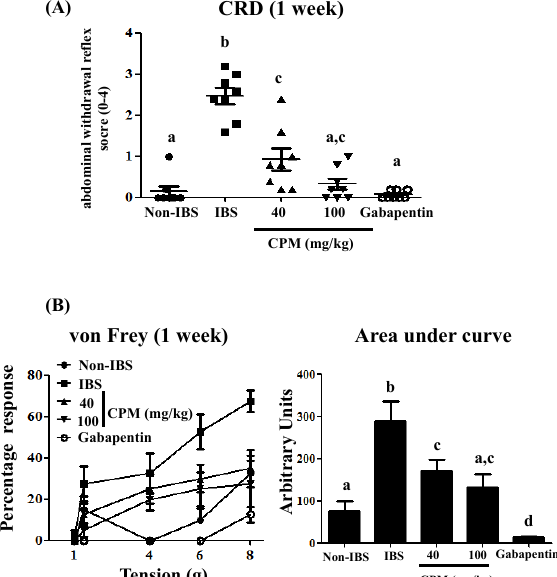
Figure 1. ( A ) Response to colorectal distension (CRD) of 60 mm Hg with a balloon catheter (duration = 20 s, interstimulus interval = 5 min) one week after DCA intracolonic administration in rats treated with calcium pyruvate monohydrate (CPM) (40 mg/kg and 100 mg/kg) or gabapentin (70 mg/kg) ( n = 8). ( B ) Evaluation of referred hyperalgesia one week after DCA administration induced by von Frey filaments (1 – 8 g) applied to the lower back (5 times for 10 s) in rats treated with CPM (40 mg/kg and 100 mg/kg) or Gabapentin (70 mg/kg). Referred hyperalgesia was measured by percentage of response to von Frey filaments and the area under the curve (AUC) was calculated. Data are expressed as means ± SEM ( n = 8). Groups with different letters statistically differ ( p < 0.05).